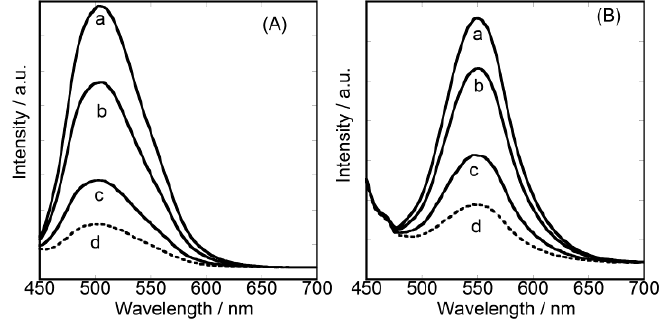
Figure 2. The luminescence spectra from the single-layered hybrid LB films of ( A ) {DFPPY/MON} and ( B ) {PPY/MON}. The excitation wavelength was 430 nm. The vertical axis denotes the intensity of luminescence at an arbitrary unit. a: in vacuum,